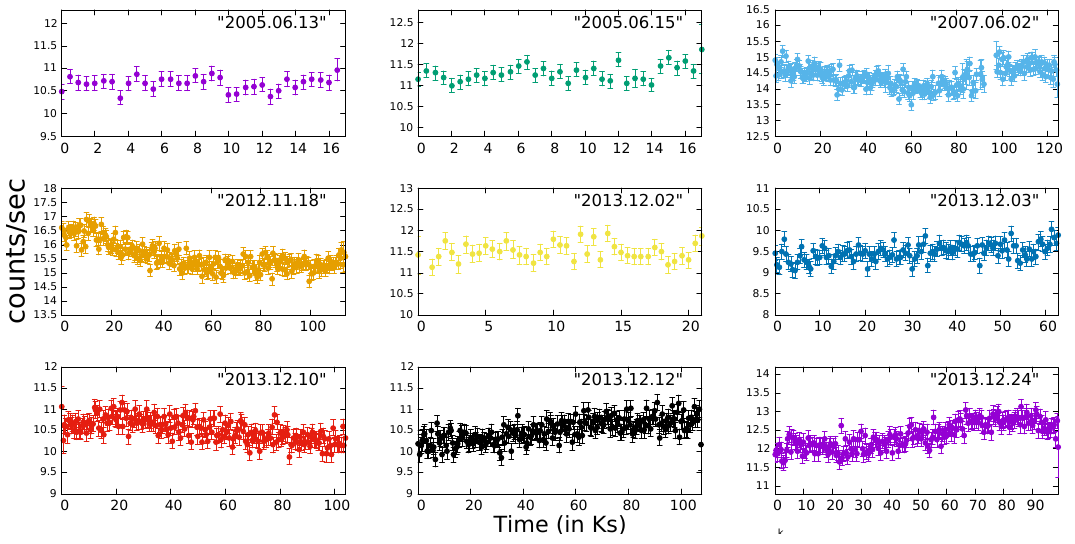
Figure 1. Light curves of H 2356-309 of XMM-Newton